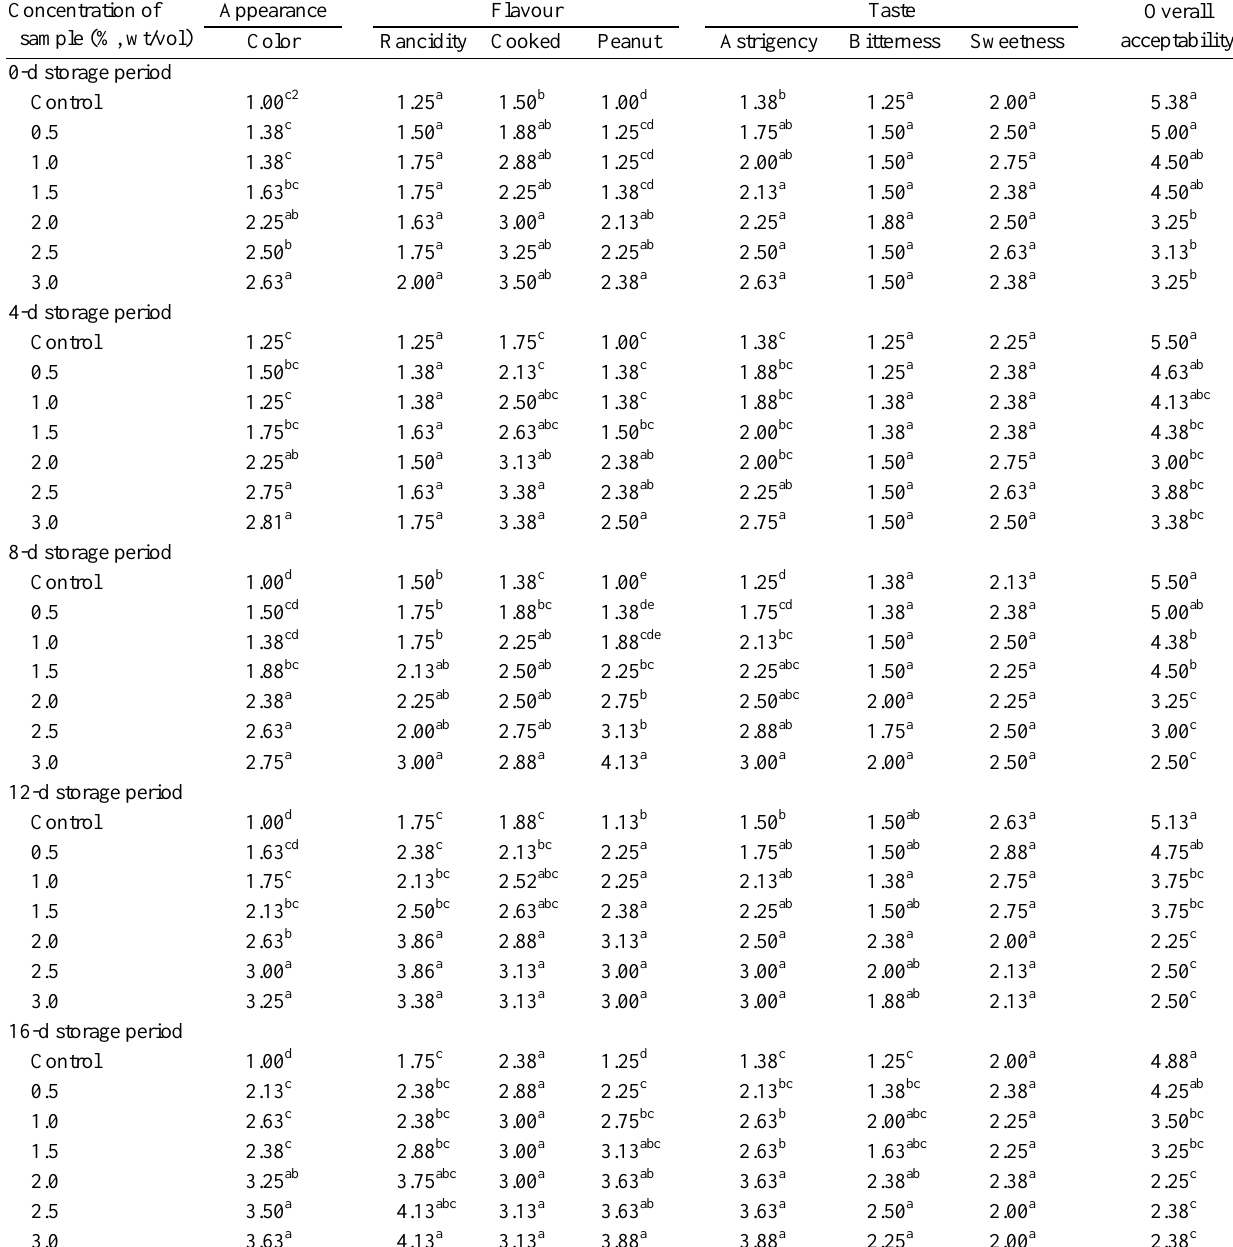
Table 2. Sensory characteristics 1 of milk supplemented with powdered peanut sprout extract microcapsules stored at 4  C for 16 d Concentration of sample (%,